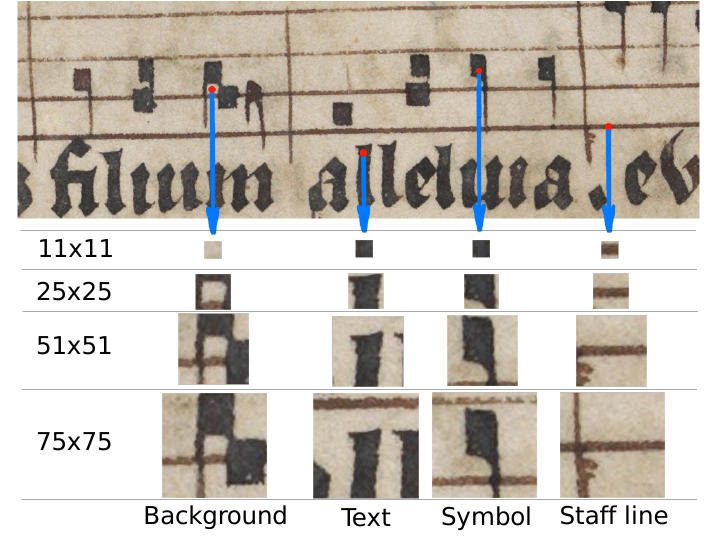
Figure 3. Block extraction examples for different CNN input size.